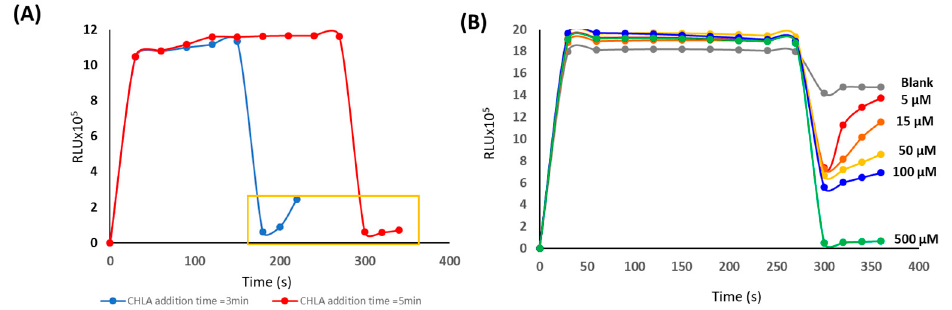
Figure 3. ( A ) Variation of the RLU in presence of CHLA (500 μ M) after 180 s (blue) and 300 s (red). ( B ) Variation of the RLU over CHLA concentration under the optima reaction conditions. ( B ) Variation of the RLU over CHLA concentration under the optima reaction